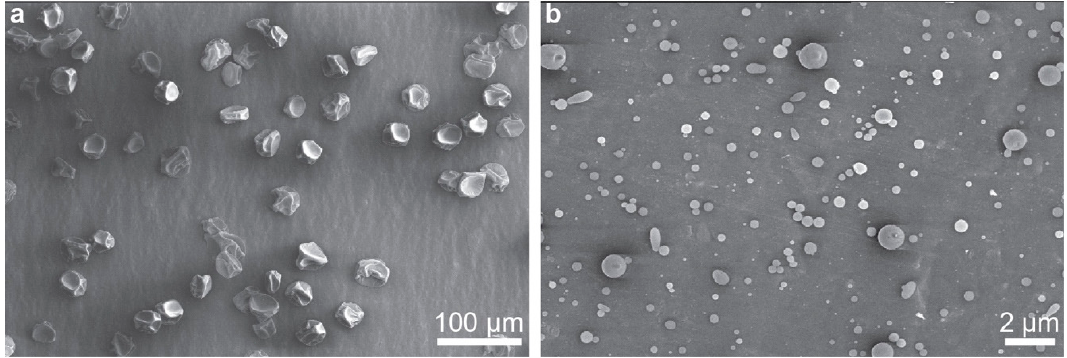
Figure 4. Beads electrosprayed from ( a ) 12 wt.% PS in THF and ( b ) 5 wt.% PVP in ethanol.